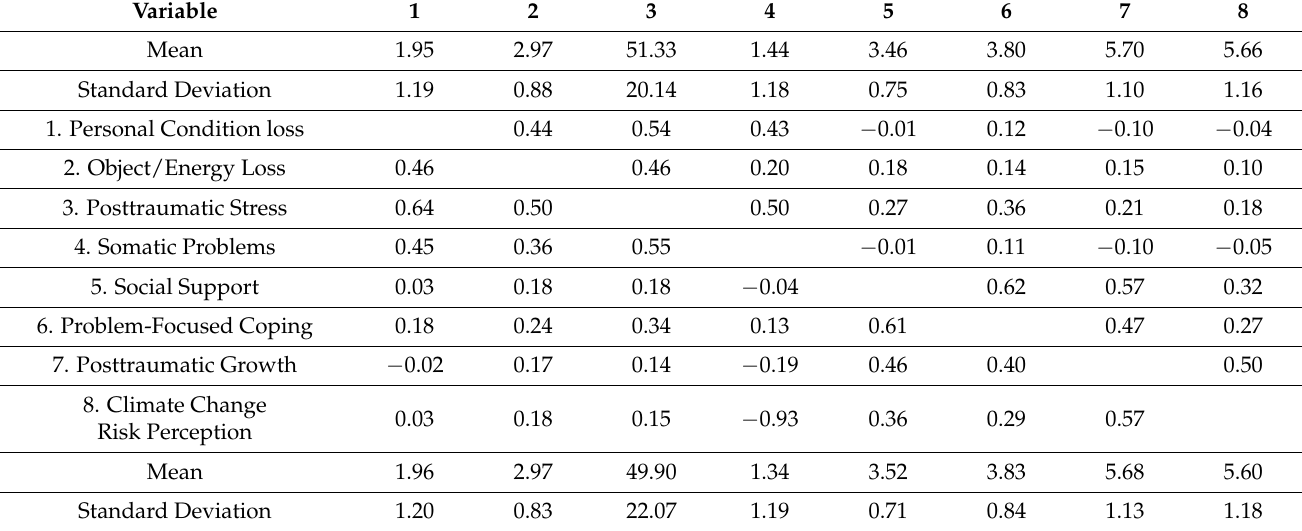
Table 3. (Study 2: Fiji) . Means, Standard Deviations, and Correlations between Measured Variables for Initial Sample ( N = 343) and Confirmatory Sample ( N = 343).